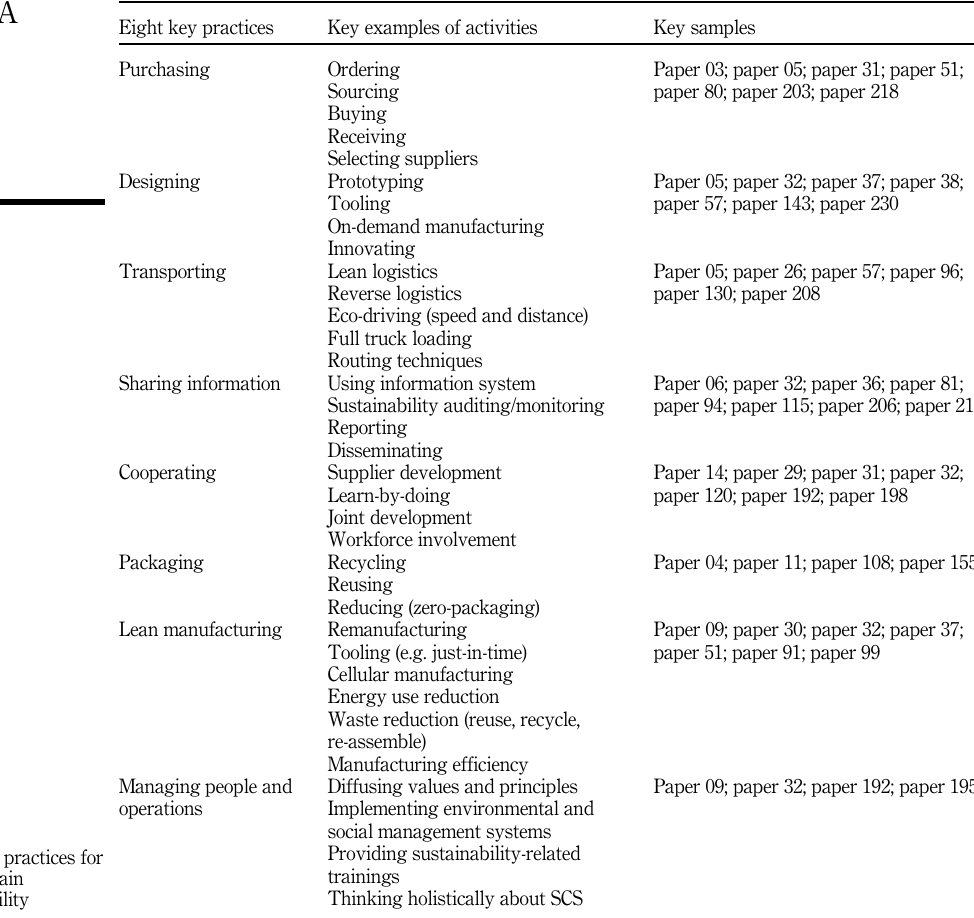
Table 1. Eight key practices for supply chain